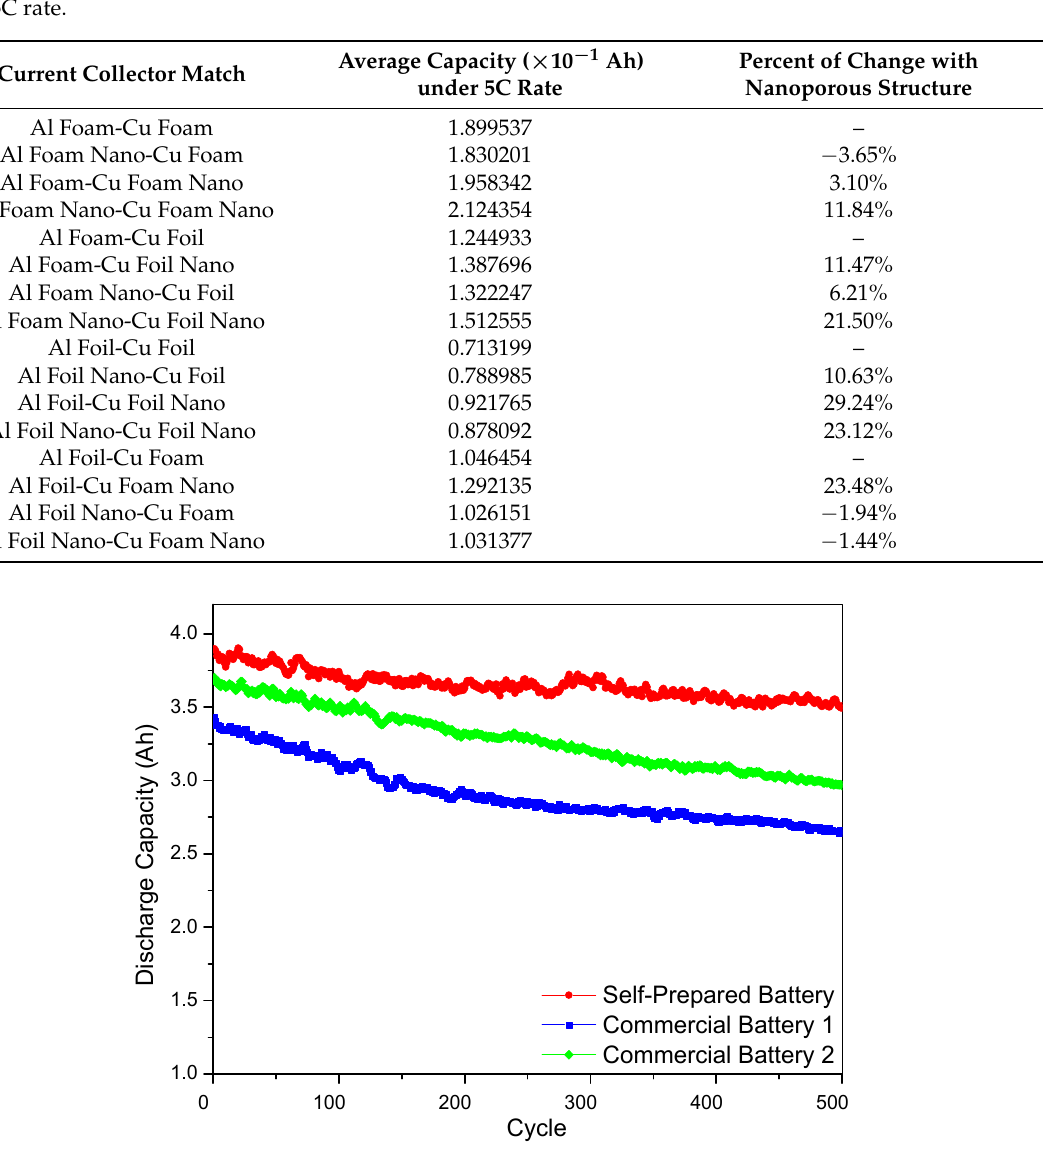
Table 3. Average capacity of lithium ion batteries with different current collector matches under a 5C rate.